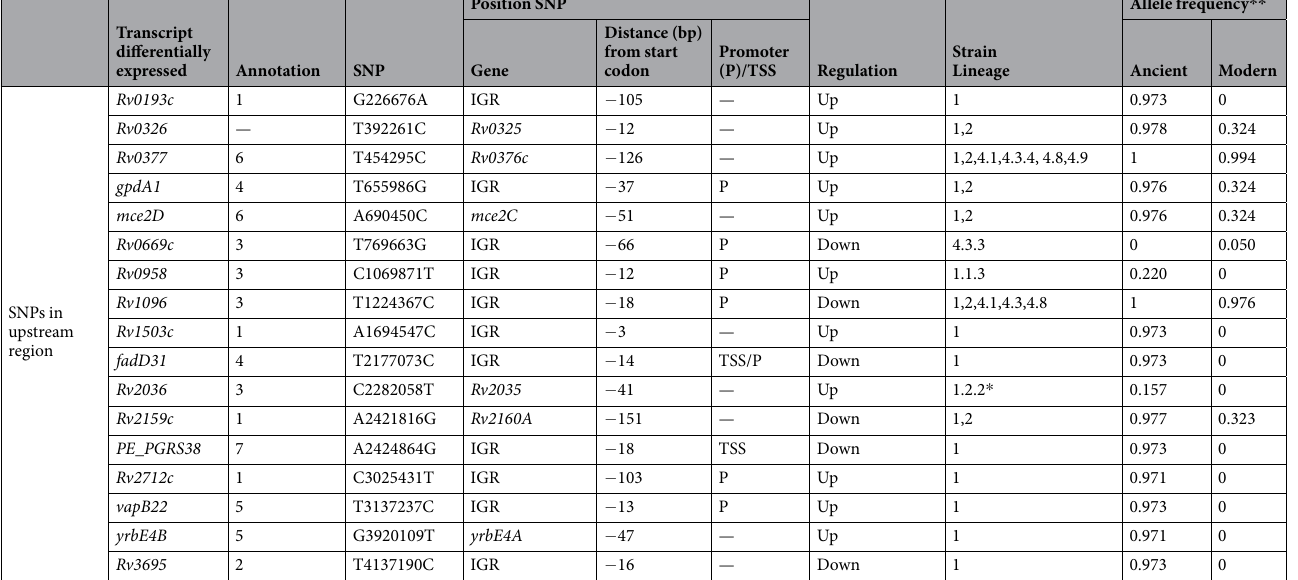
Table 1. Putative functional SNPs associated with expression ( cis- eQTLs with allele frequencies > 5%; adjusted p < 0.05). Table showing the candidate transcripts differentially expressed due to SNPs in upstream intergenic regions (IGRs) or within the upstream gene. Annotation of the transcript differentially expressed: 1 – Conserved hypotheticals, 2 – Cell wall and cell processes, 3 – Intermediary metabolism and respiration, 4 – Lipid metabolism, 5 – Virulence, detoxification, adaptation, 6 – Regulatory proteins, 7 – PE/PPE, 8 – information pathways. Distance of the SNP location from the start codon of the transcript is showed as negative when it is upstream and positive when it is located within the gene. TSS = Transcriptional Start Site. * Only one or two samples from the lineage out of the 3 analysed. ** Allele frequency refers to the fraction of strains harbouring the SNP in a larger data set (n = 6,218) 50 ; “—“ when not